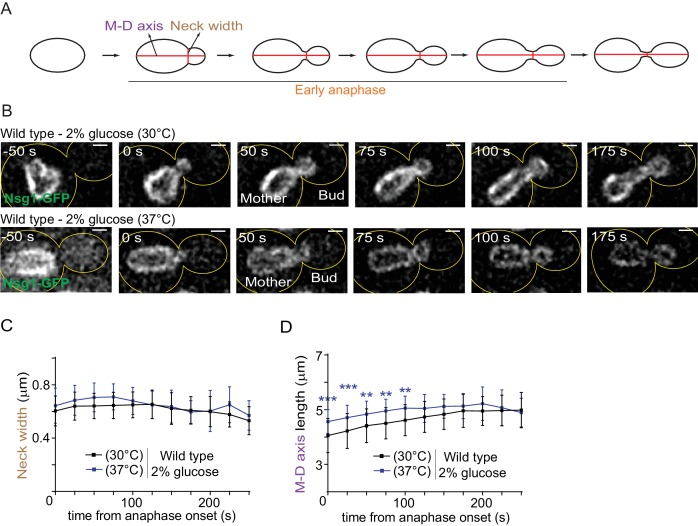
The morphology of the dividing nucleus is not significantly affected by heat stress.(A) Scheme of the nuclear division imaged in B. B) Dividing nuclei in anaphase (average intensity projection, outline of the cell in yellow, scale bar is 1 µm). 0 s was set as the beginning of anaphase (the frame when the nucleus starts entering into the bud). (C–D) Quantification (Mean ± SD of 46 and 35 cells, respectively, for 30°C and 37°C, three to six independent pooled experiments) of the neck width and the mother-daughter axis length. ≥11 cells per time point were analyzed (for 225 and 250 s, this cut off was 4). 2-way ANOVA test, **p<0.01.